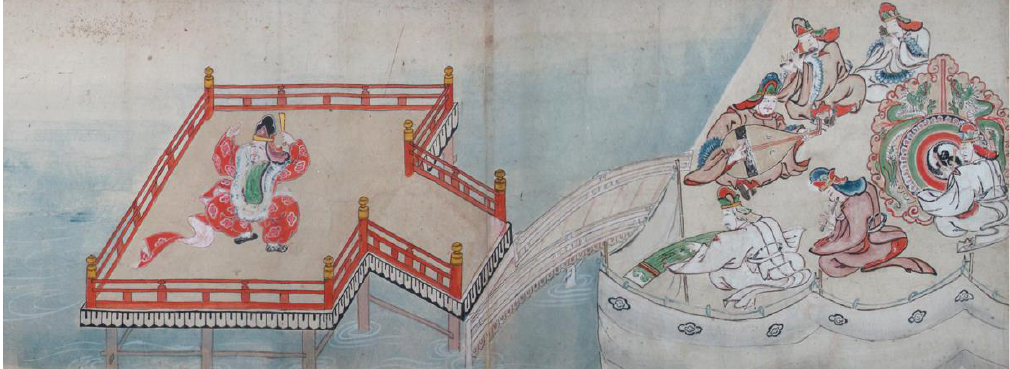
Figure 4. Tsuneishi Hachimangū engi 恒石八幡宮縁起 (The story of Tsuneishi Hachiman Shrine, 1478). Tsuneishi Hachiman Shrine, Ube City, Yamaguchi prefecture. Courtesy of the Hachiman Project, University of Heidelberg. At https://kjc-sv038.kjc.uni-heidelberg.de/hachiman/#O4617.2/, accessed on 15 June 2022.